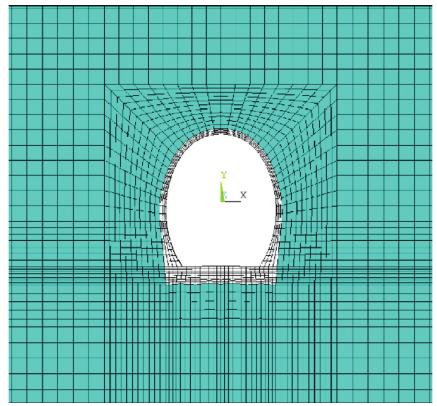
Figure 8: Computational model.